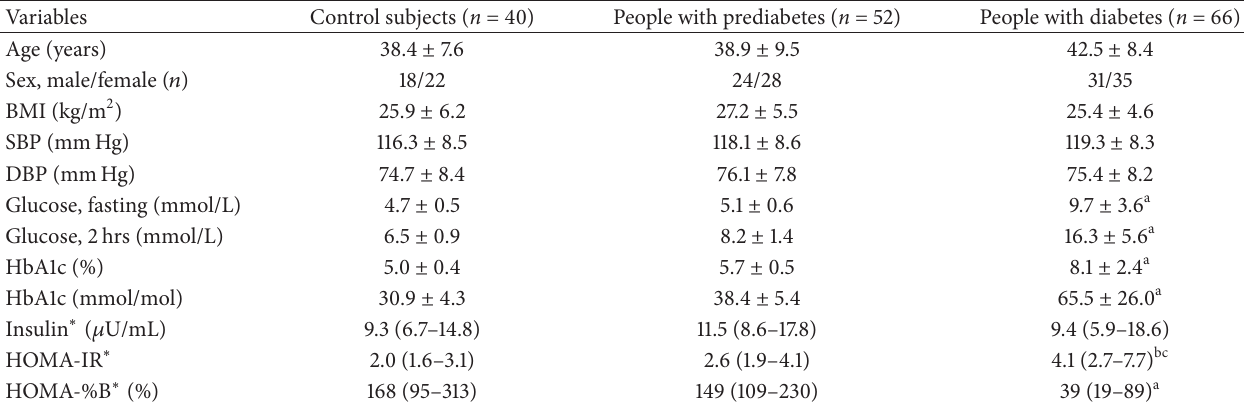
Table 1: Clinical and biochemical characteristics of the study subjects.